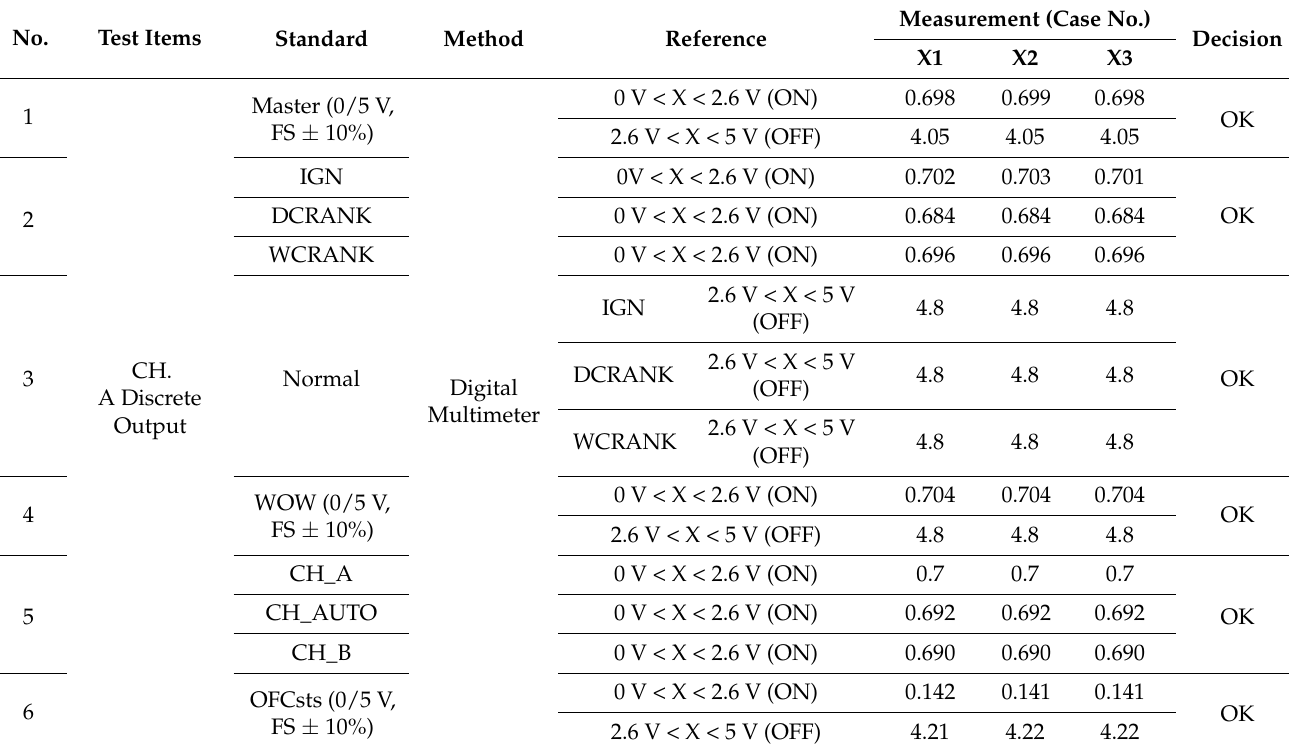
Table 3. Result of test bench functional test (discrete output_CH_A).